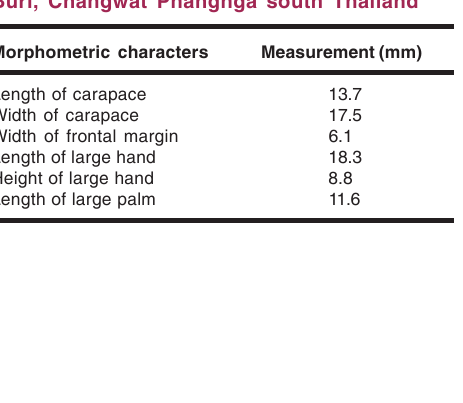
Table 1. Selected morphometric measurement (in mm) of the largest male specimen of Phricotelphusa callianira